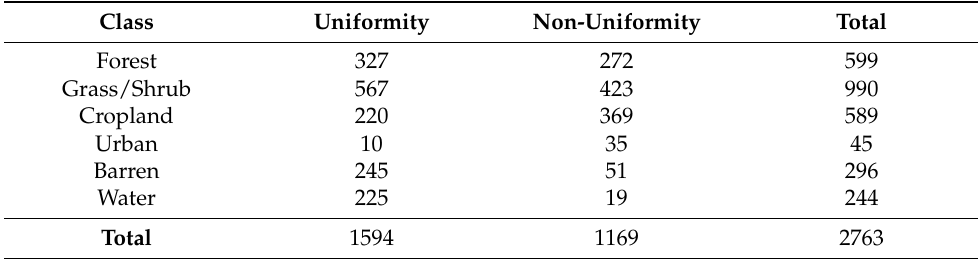
Table 7. Spatial uniformity of 300 m scale for DCP validation data.